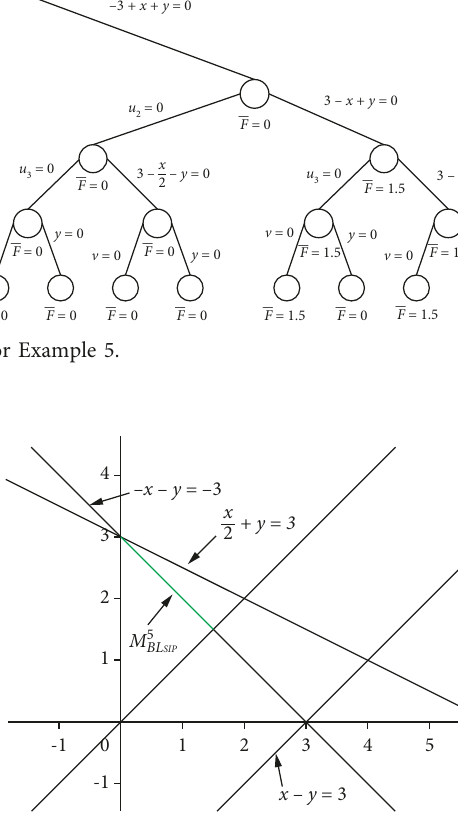
SIP which is results of